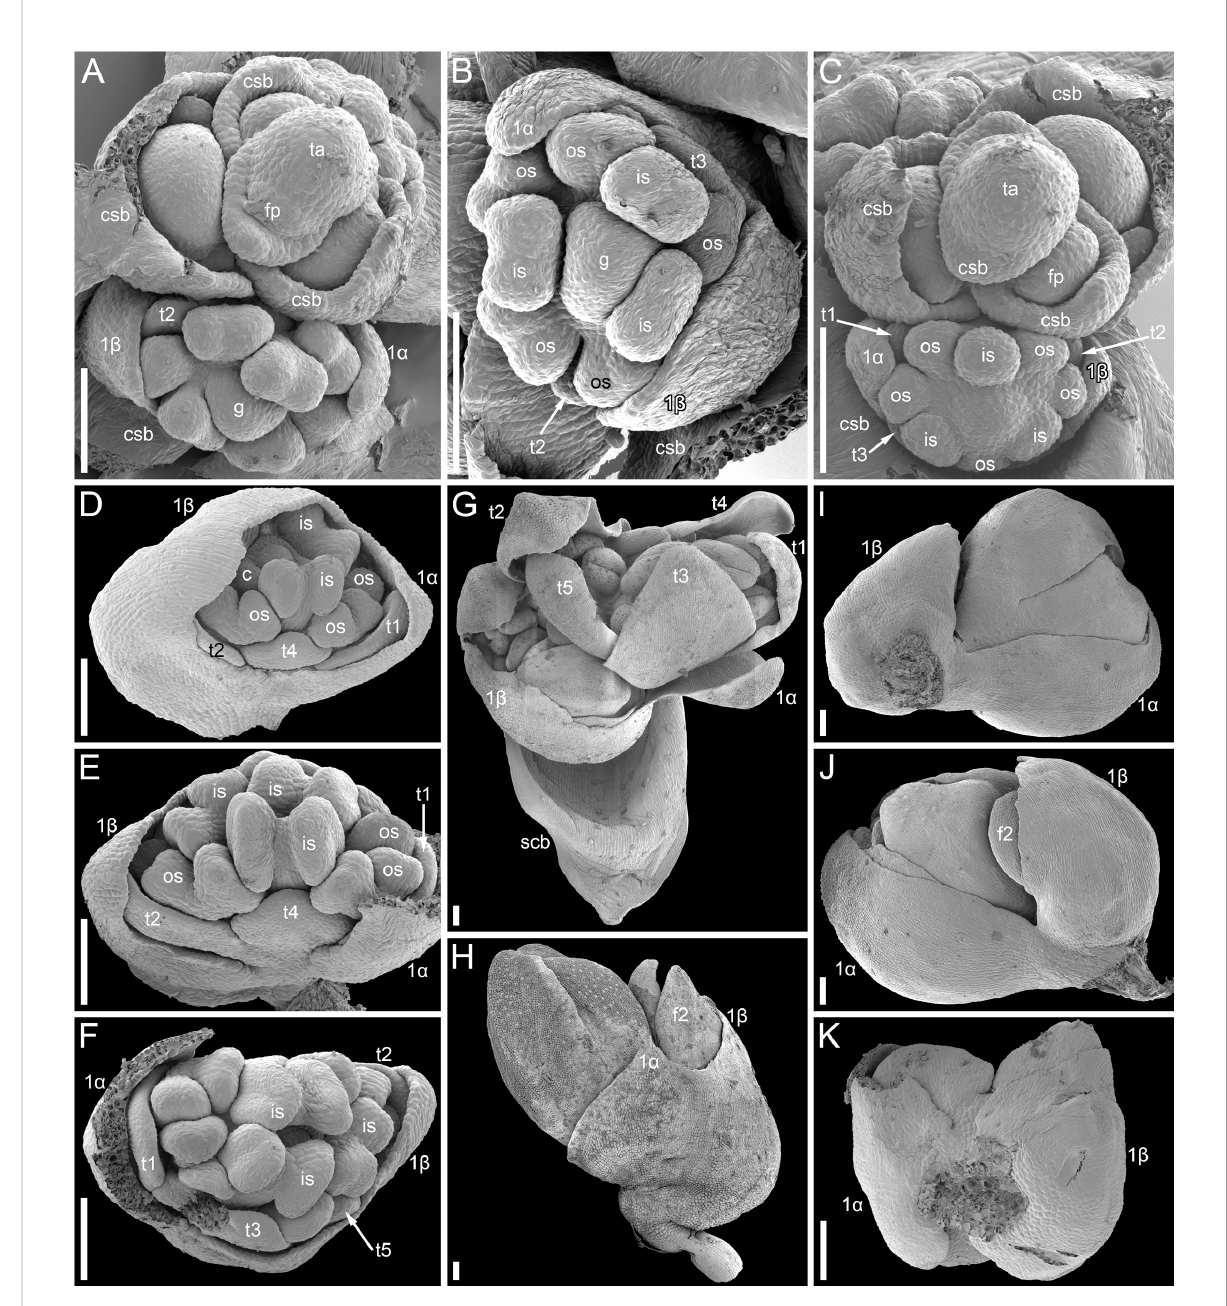
FIGURE 4 Flower development in the tepal-like bract mutant of Fagopyrum esculentum (SEM). (A – C) Images taken from different sides of a young thyrse with fl owers at successive developmental stages. (B) The oldest cyme of the specimen. The same cyme is shown in the lower part of (A) . The fi rst fl ower of this cyme is at Stage 7 (note the triangular gynoecium with no evidence of ovule initiation as well the occurrence of thecae in some stamens). The a and b prophylls are largely free (or only basally united). (C) View showing cyme adjacent to that in (B) , also visible in the upper right part of (A) . The fi rst fl ower of this cyme is at Stage 6 (the gynoecium is dome-shaped rather than triangular, stamen thecae not yet initiated). (D) . Flower at Stage 8 (the ovule is initiated, but anthers of inner stamens are shorter than at Stage 9). The a and b prophylls are fused to form a pronounced tube. (E, F) Two views of a fl ower at Stage 9 (anthers of the inner whorl stamens exceed the gynoecium). The a and b prophylls are united on the anterior side of the fl ower (F) , but free on the posterior side (E) . (G) Cyme similar to that in (E, F) , but at a later developmental stage. (H – J) Cymes with closed mature fl oral buds. (H) The prophyllar sheath is well-pronounced. (I, J) Two views of a cyme with the a and b prophylls are only basally united. (K) Cyme with completely free prophylls. 1 a , 1 b , prophylls of the fi rst fl ower of a cyme; c, carpel apex; csb, cyme-subtending bract; f2, the second fl ower of a cyme; g, gynoecium; is, inner whorl stamen; os, outer whorl stamen; t1-t5, tepals in in order of their inferred (pre)patterning; thyrse apex. Scale bars = 100 µm (A – K)